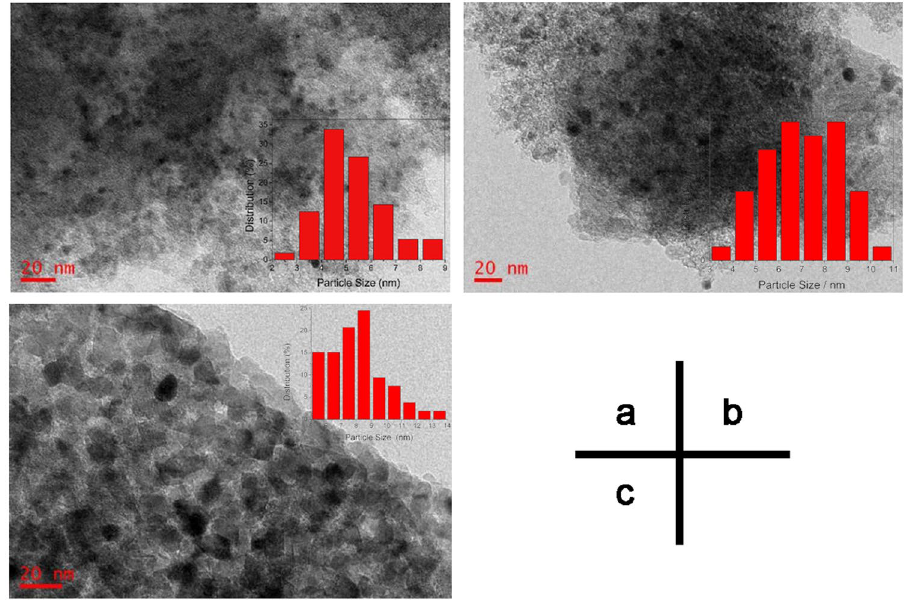
Figure 3. TEM images and Pd nanoparticles size distributions of 1%Pd/10% Ⓕ -TiO 2 /AC ( a ), 2%Pd/10% Ⓕ - TiO 2 /AC ( b ), 3%Pd/10% Ⓕ -TiO 2 /AC ( c